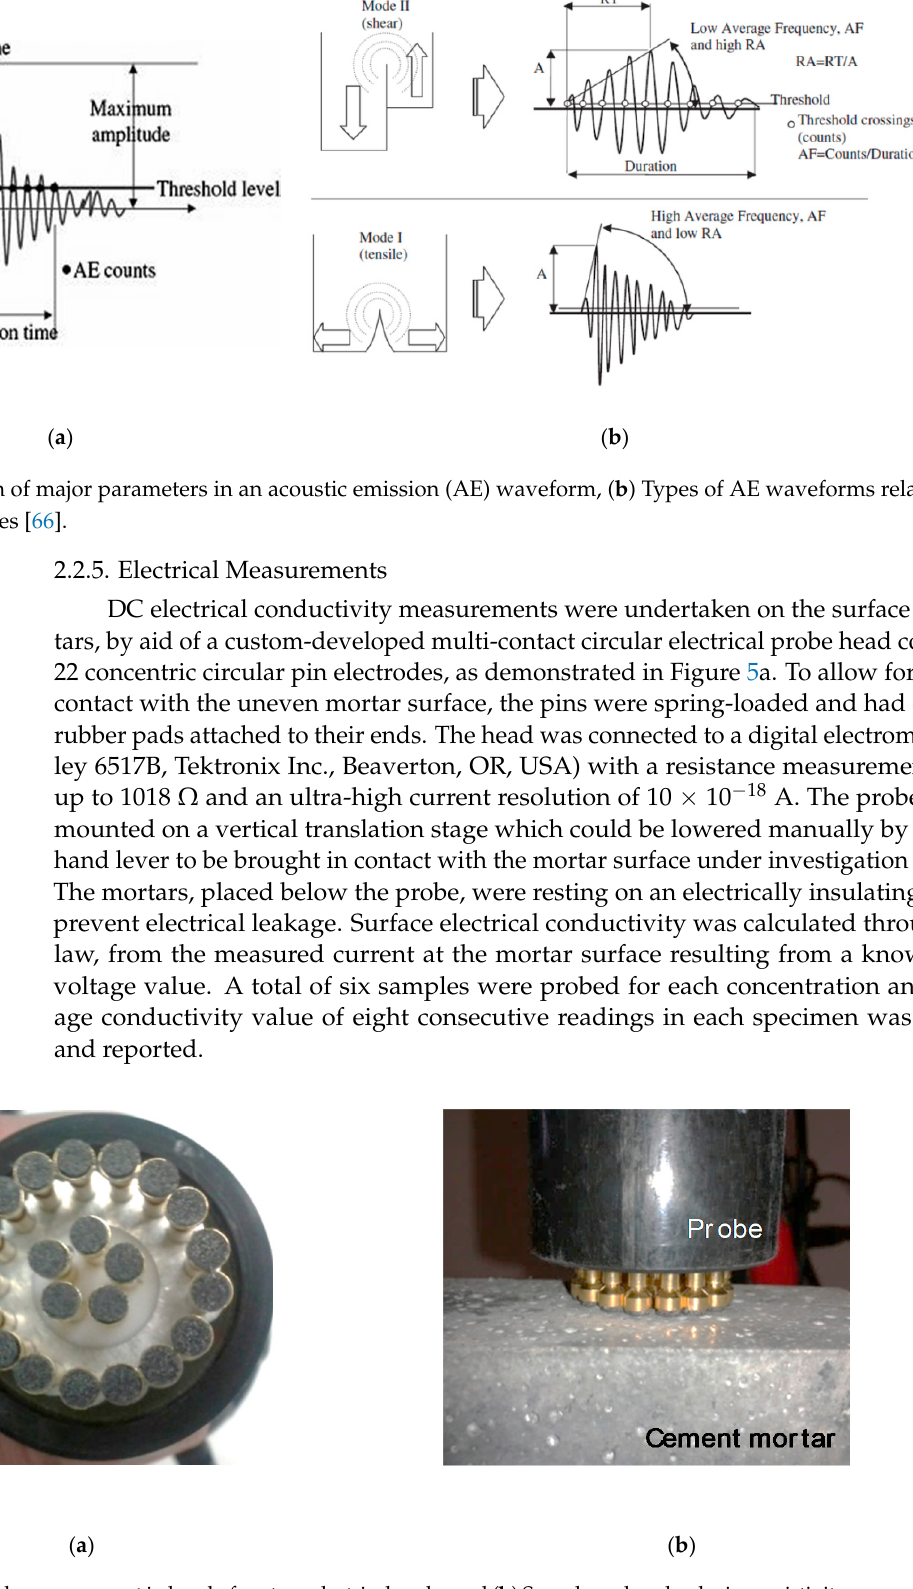
Figure 4. ( a ) Definition of major parameters in an acoustic emission (AE) waveform, ( b ) Types of AE waveforms relating to different fracture modes [66].